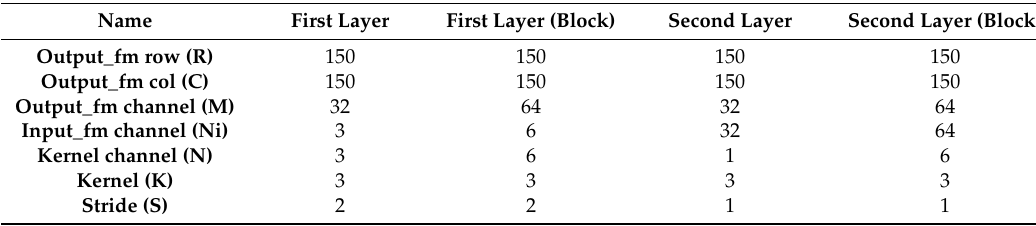
Table 3. Parameter of the two network layers.